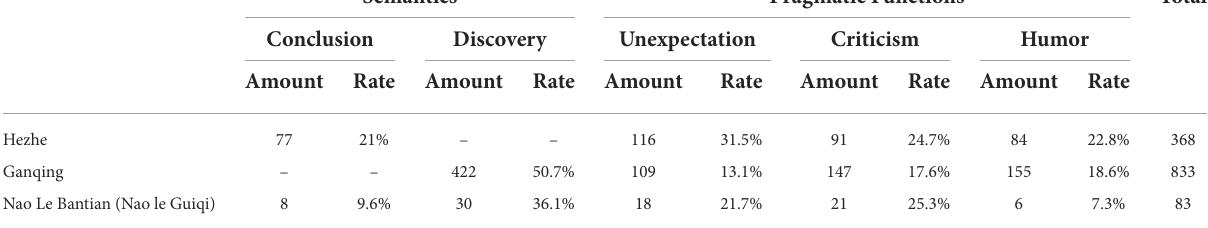
TABLE 1 Distribution of three mood words.